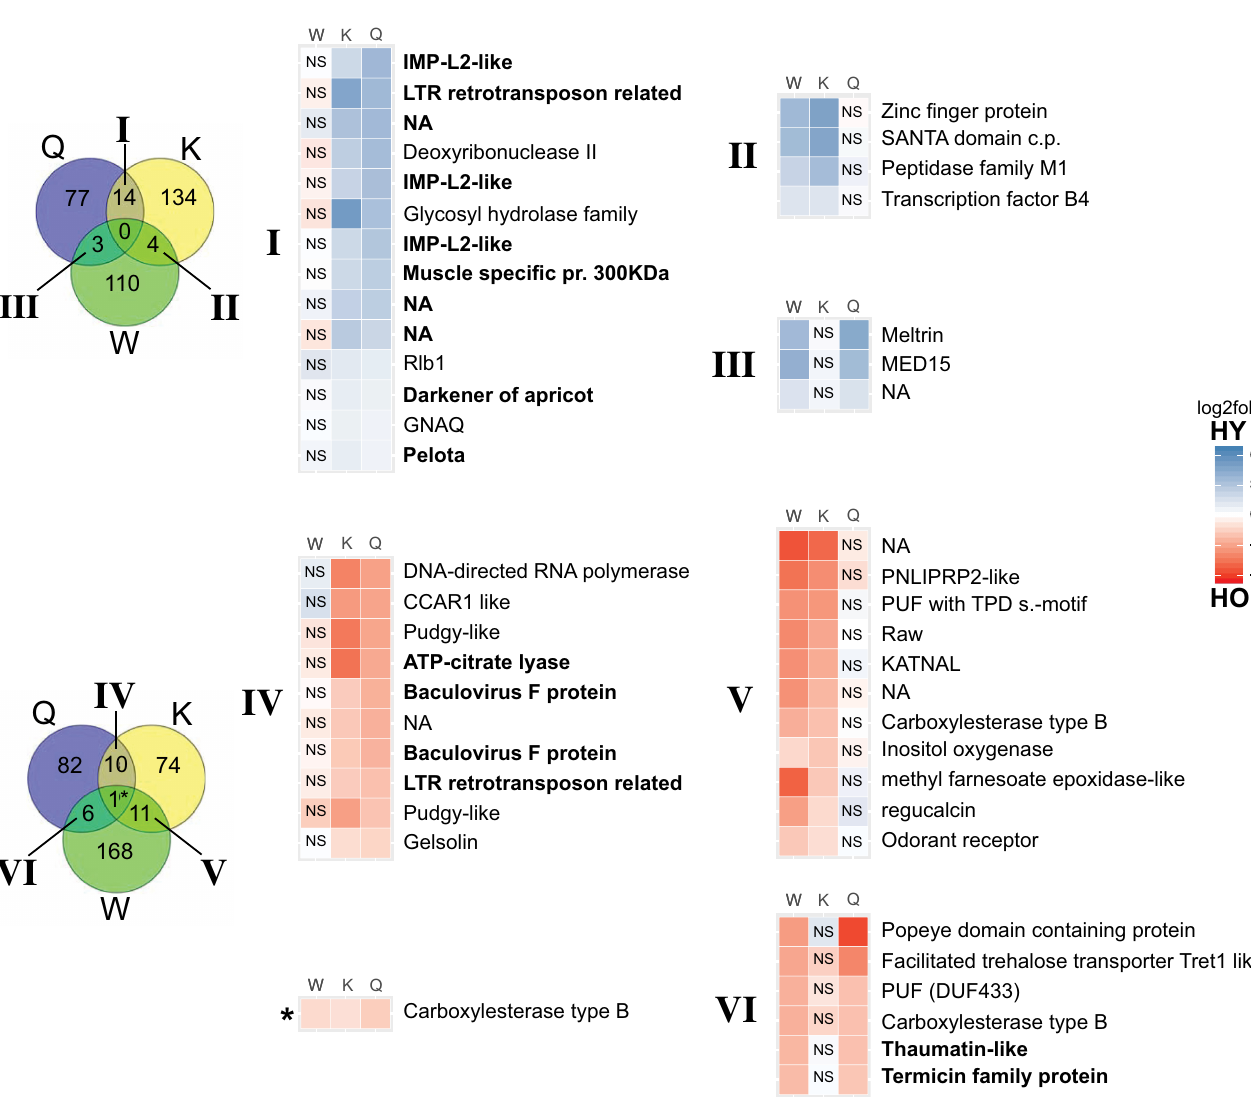
Fig 4. Venn diagrams and heatmaps of differentially expressed transcripts. Shared differentially expressed transcripts (DETs) with age (old vs young) between C . secundus queens (Q), kings (K) and workers (W). The heatmaps depict the log2fold changes in expression within castes, only DETs. Each row corresponds to a DET and each column to a caste. NS: differential expression not significant (p adj > 0.05); transcripts in bold are discussed in the text. Roman numerals link the DETs shared between castes to the heatmaps. (A) DETs more highly expressed in young compared to old individuals (HY). (B) DETs more highly expressed in old compared to young individuals (HO). In Venn diagrams, blue: old queens vs young queens, yellow: old kings vs young kings and green: old workers vs young workers.